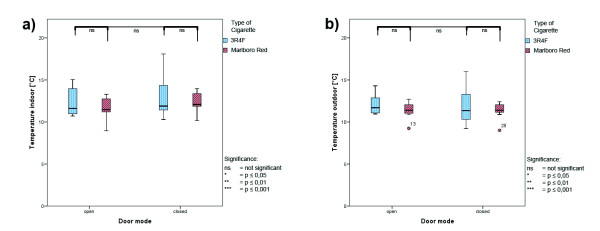
Climate parameters during ETS measurement - temperature. a) indoor temperature; b) outdoor temperature; red: Marlboro Red; blue: 3R4F reference cigarettes; values are averages for the total time interval.